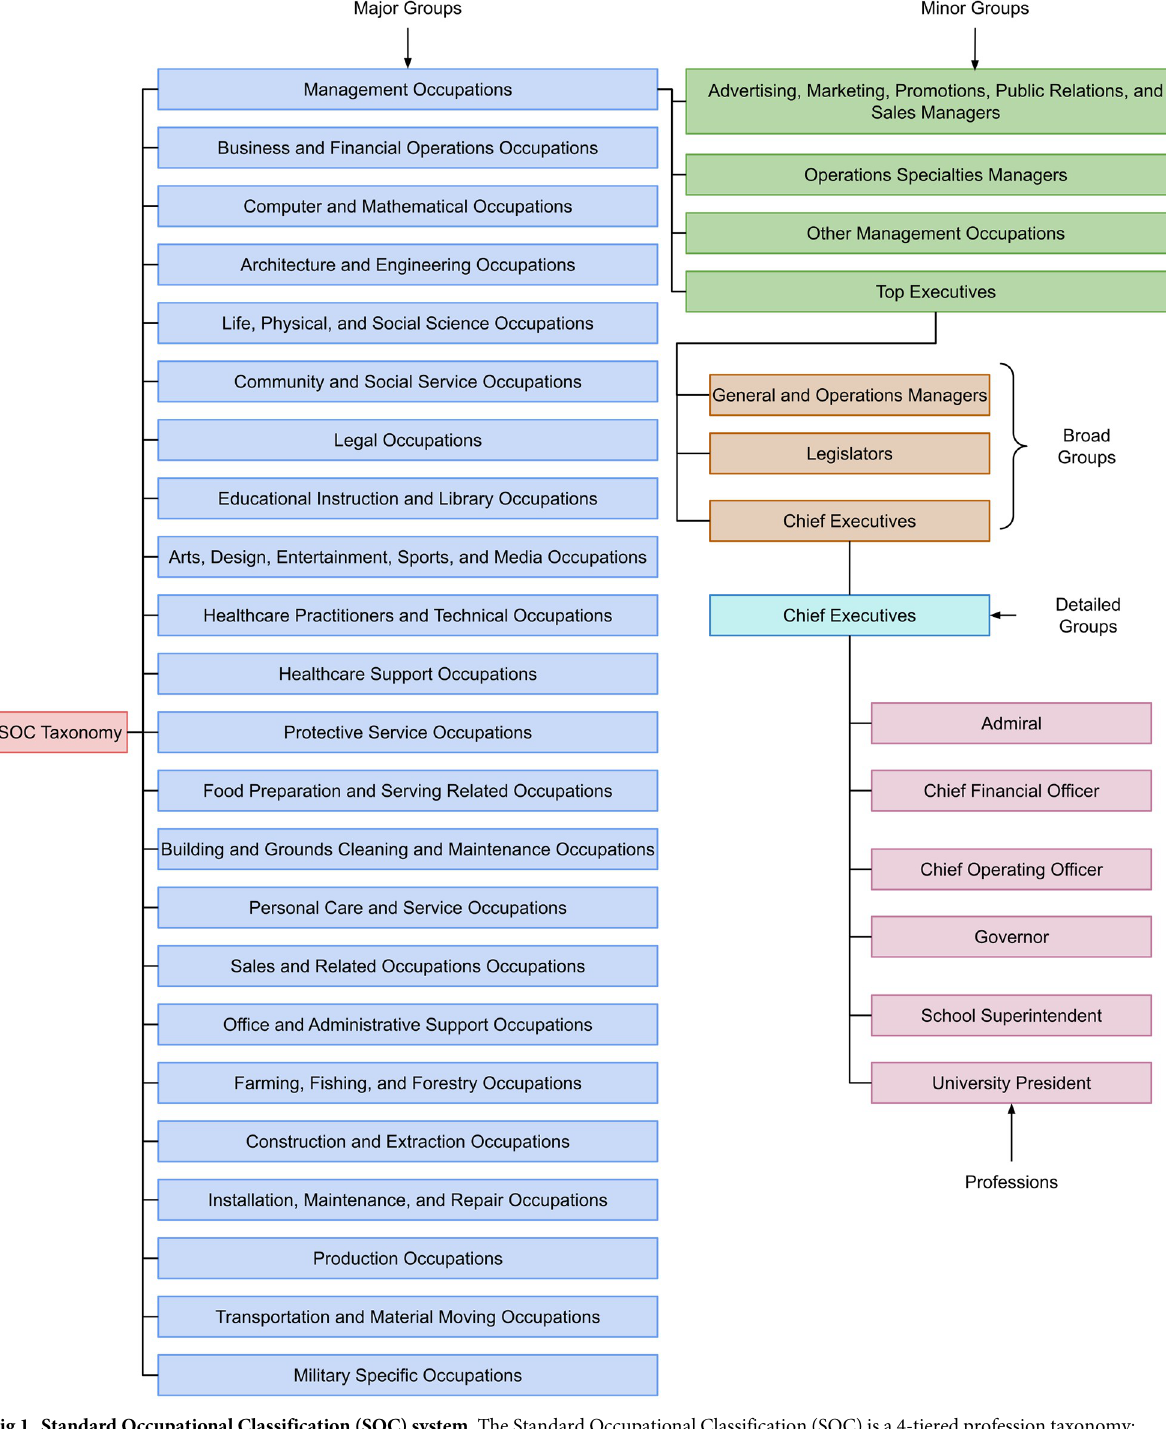
PLOS ONE | https://doi.org/10.1371/journal.pone.0267812 May 18, 2022 8 /